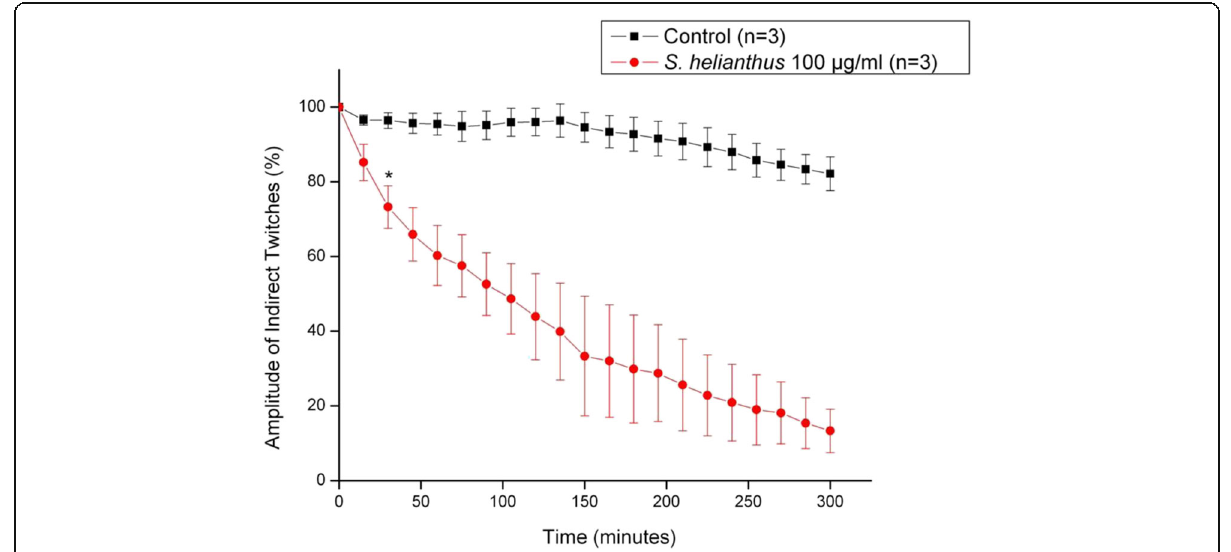
Fig. 7 Effects of S. helianthus extract (100 μ g/mL) upon indirect evoked twitches on mouse phrenic-diaphragm preparation . The ordinate represents the % amplitude of twitches relative to the initial amplitude. The abscissa indicates the time (min) after the addition of the extract to the organ bath. Vertical bars represent the SEM; *indicates the point from which there are significant differences relative to control ( p < 0.05)